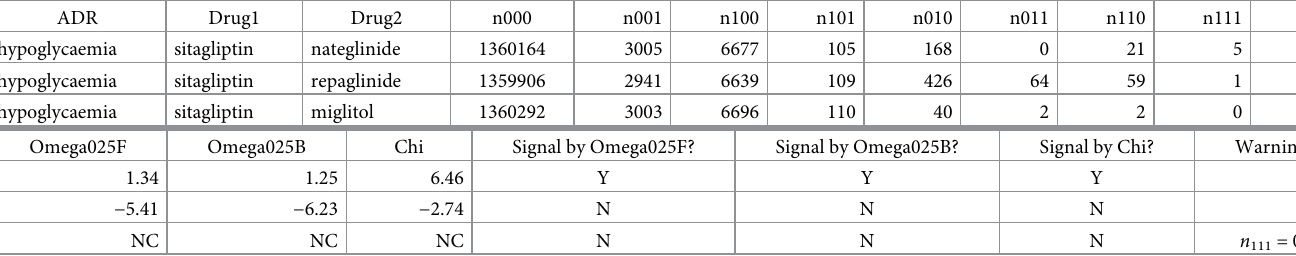
Table 6. Outputs of analysis for implementing the SignalDetDDI